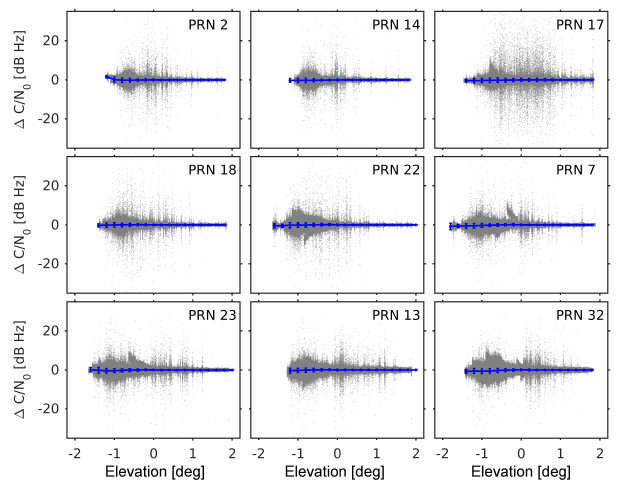
Figure 11. Same as Fig. 9, however, showing (cid:49)C /N 0 , the differ- ence of the two O/L density ratios, as a function of elevation angle.